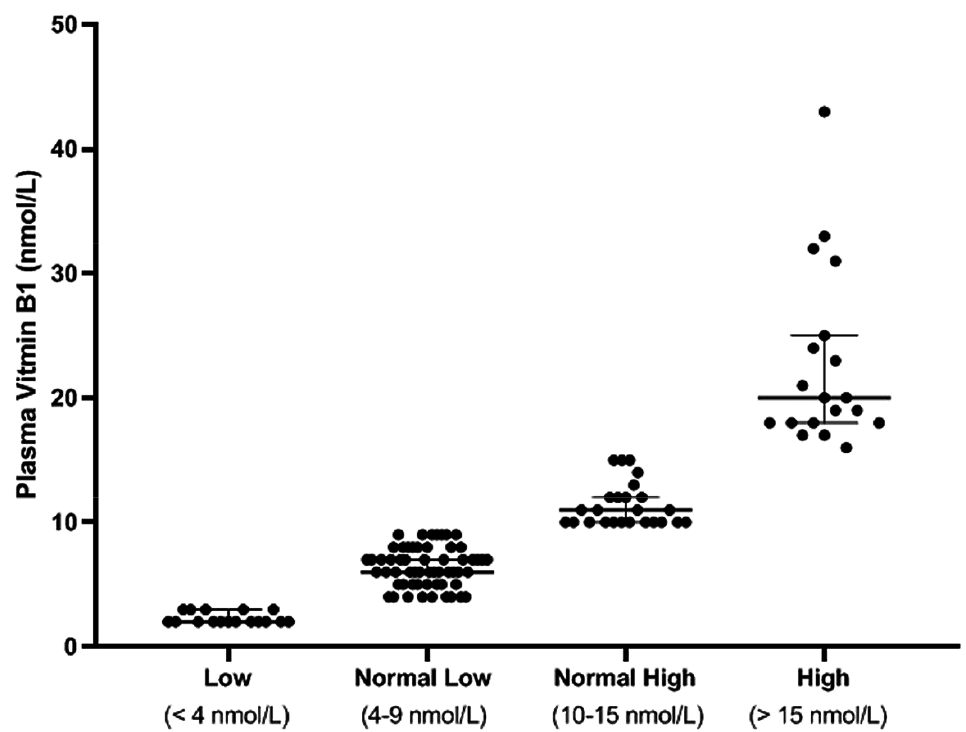
Figure 1. Plasma vitamin B1 levels. The patient cohort is divided into four groups with the normal range divided equally into normal low and normal high.